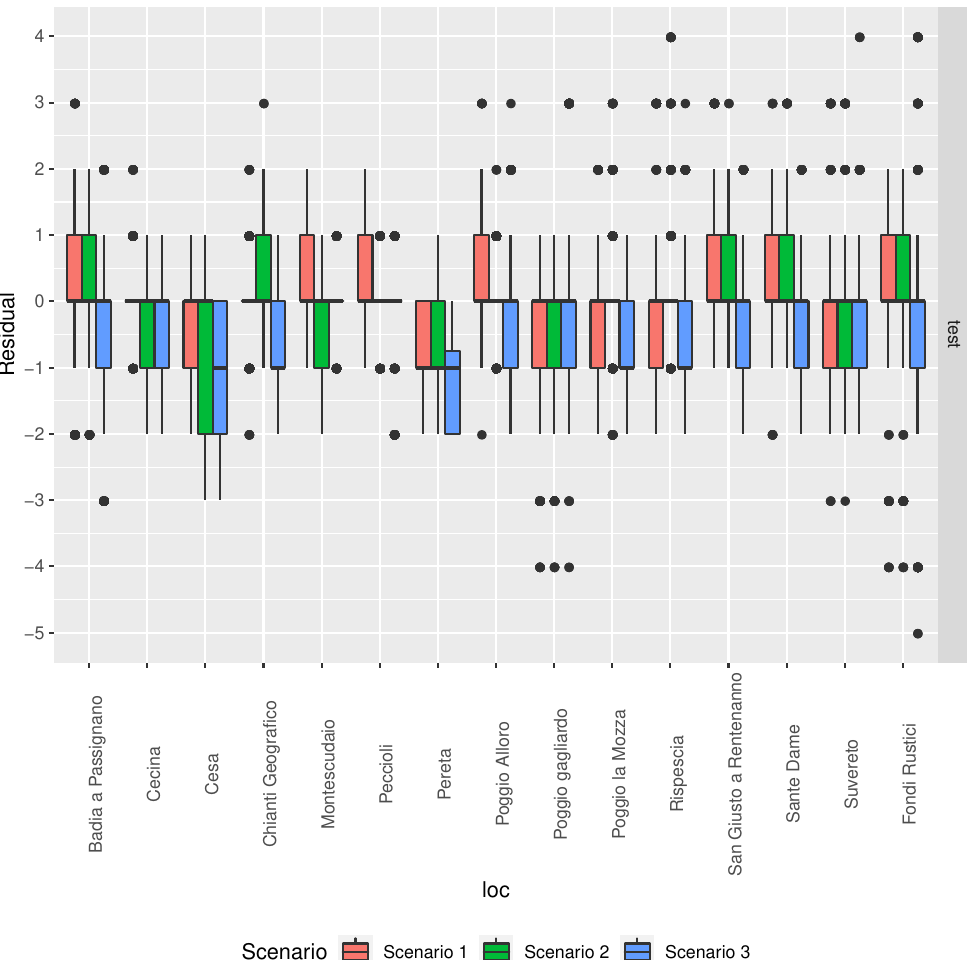
Figure 13. Comparison of the residuals by location for the different models’ in the scenarios described in Table